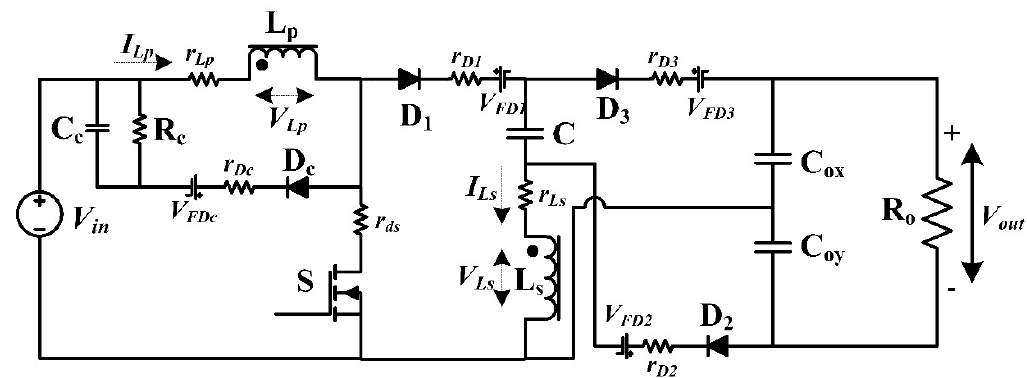
Figure 10. Proposed converter with ESR of MOSFET, coupled inductor, switch and diode voltage drops.